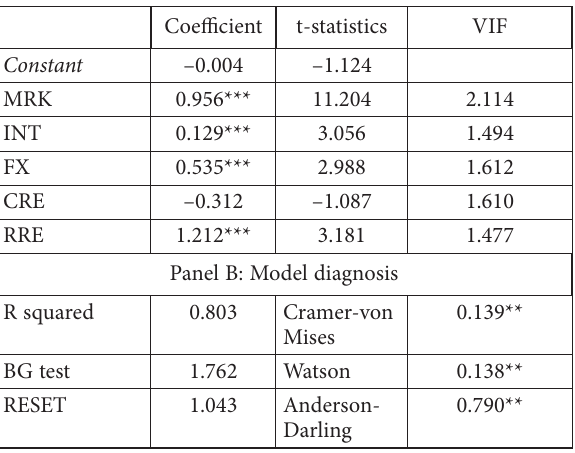
Table 2. OLS estimates of bank stock return